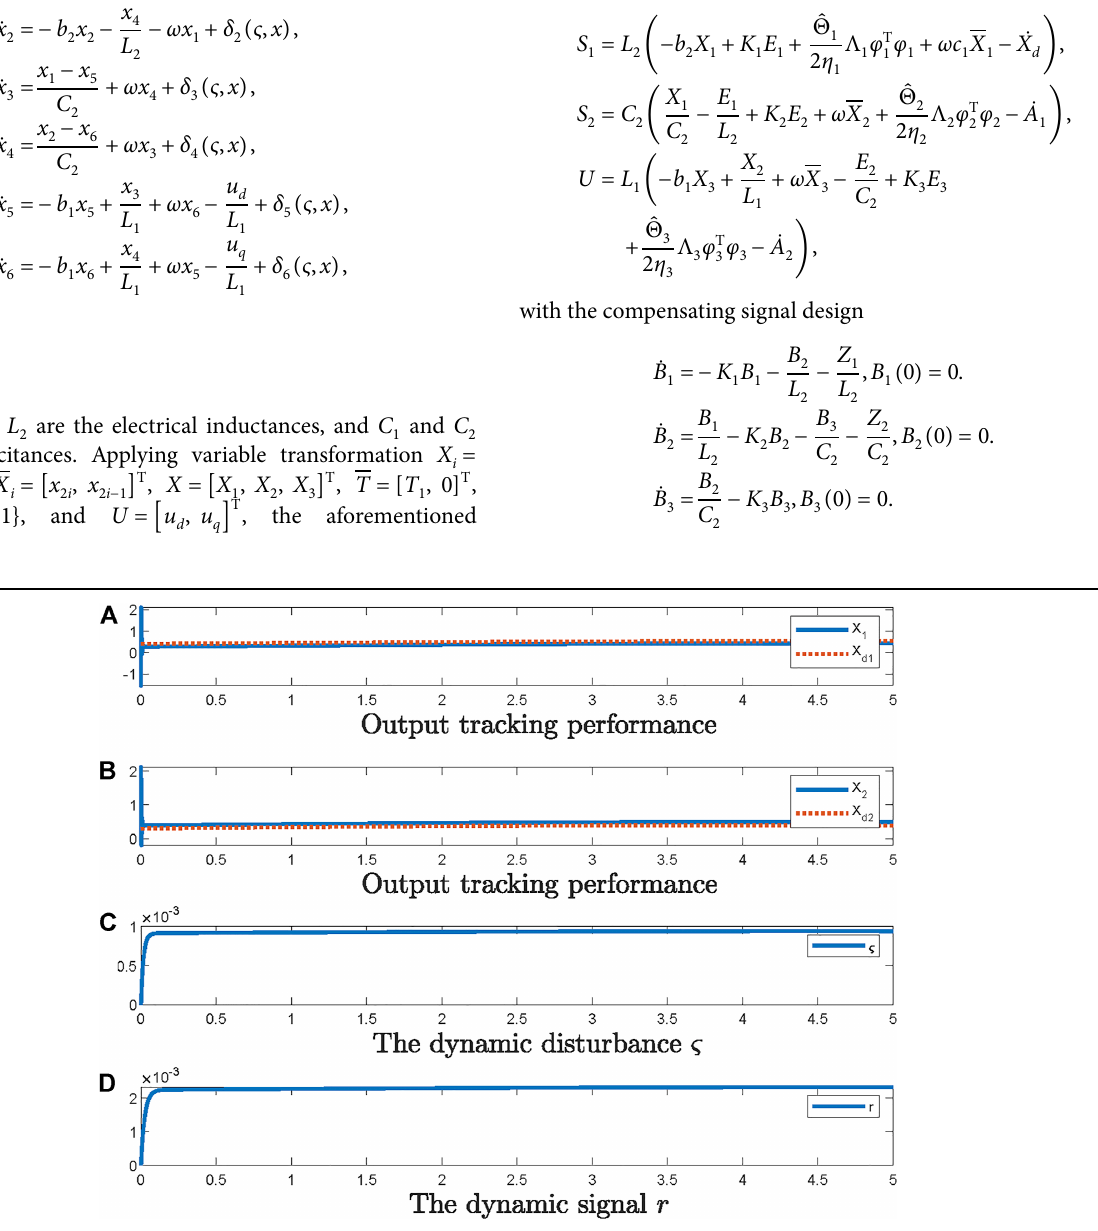
FIGURE 1 | Output tracking performance and evolution of dynamic uncertainties.